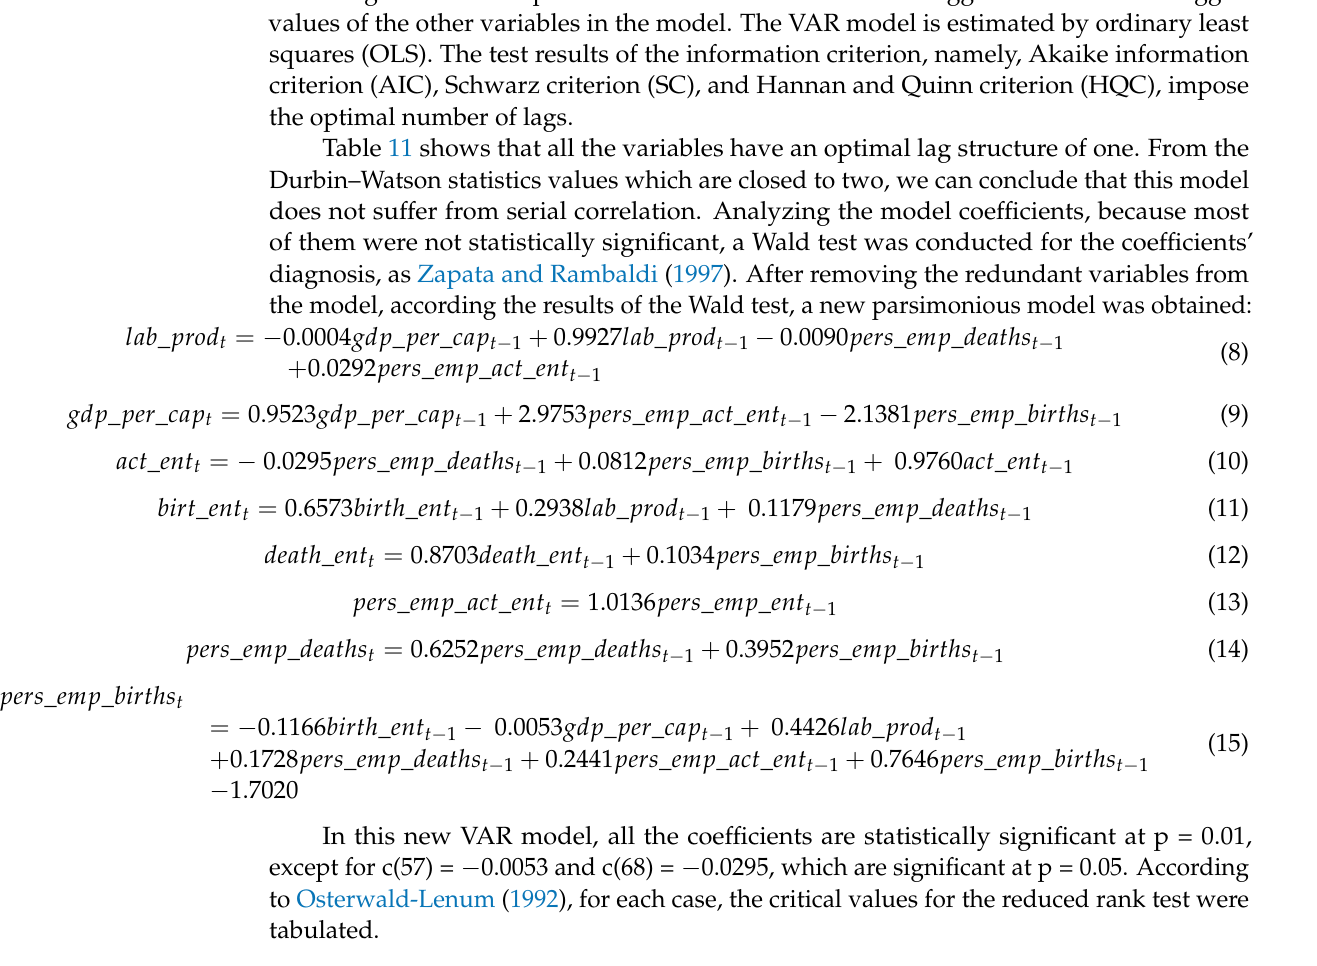
Table 11. VAR lag order selection